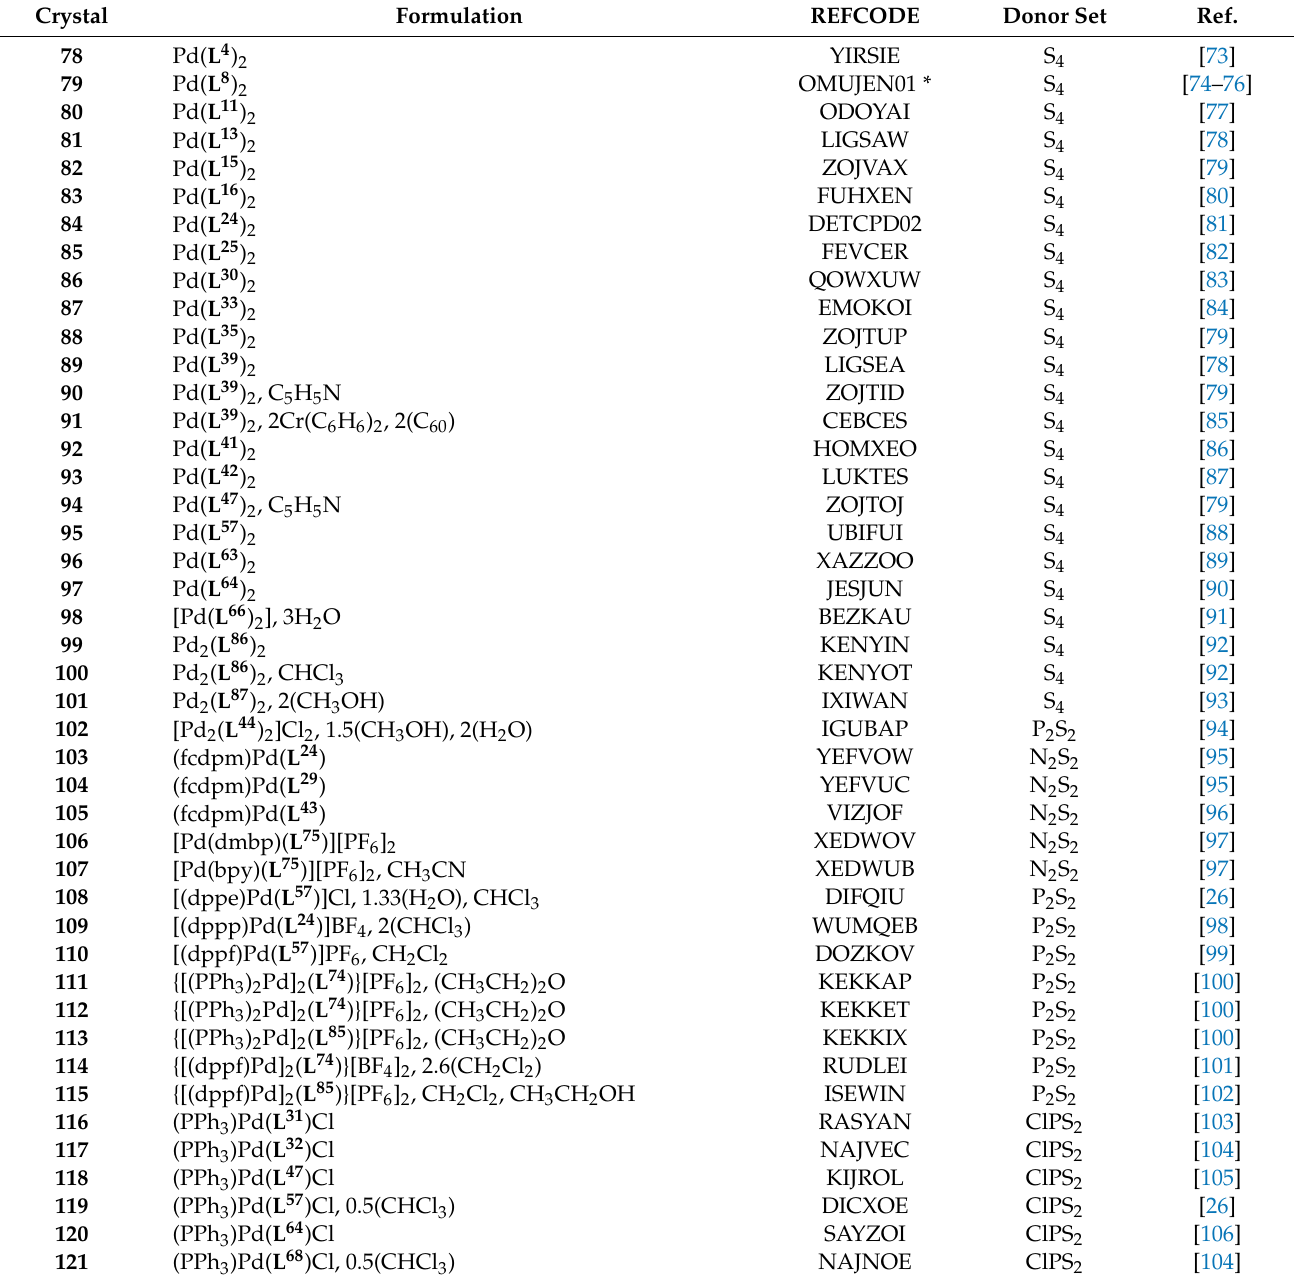
Table 4. Summary of palladium dithiocarbamate structures established by X-ray crystallography. See Table 1, Figure 2, and the Abbreviations